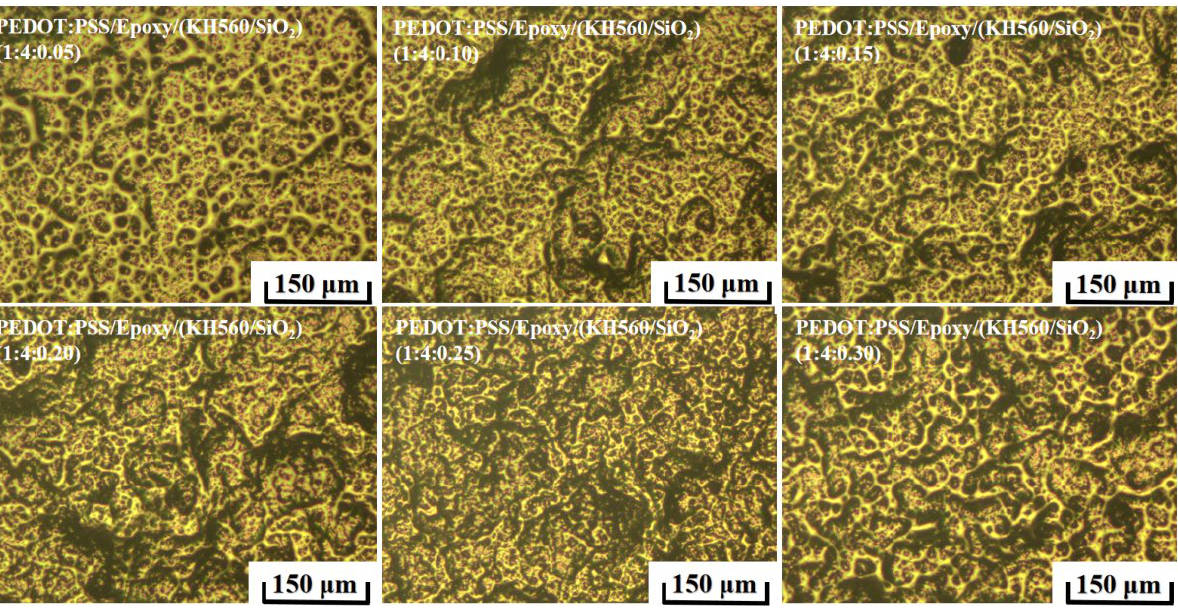
Figure 7. Microscope morphology photos of PEDOT:PSS/epoxy/(KH560/SiO 2 ) coatings (top light source) with different P:E:K ratios.